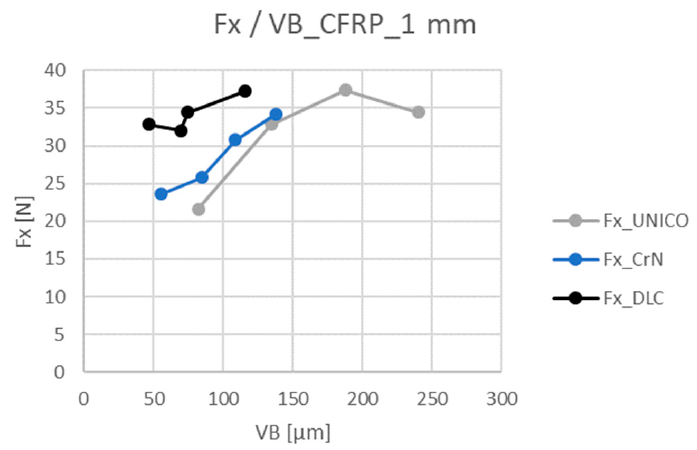
Figure 13. Dependence of the cutting force component F x on wear, laminate thickness 1 mm. F x —cutting force in x direction. VB—flank wear.